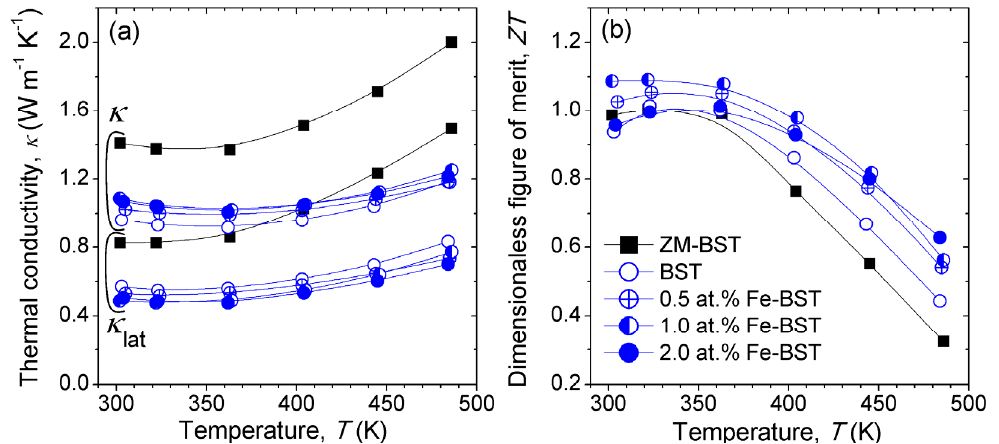
Figure 4. Temperature dependence of ( a ) the thermal conductivity ( κ ) and lattice thermal conductivity ( κ lat ) and ( b ) dimensionless of figure of merit ZT of ZM-BST, BST, and Fe-BTS